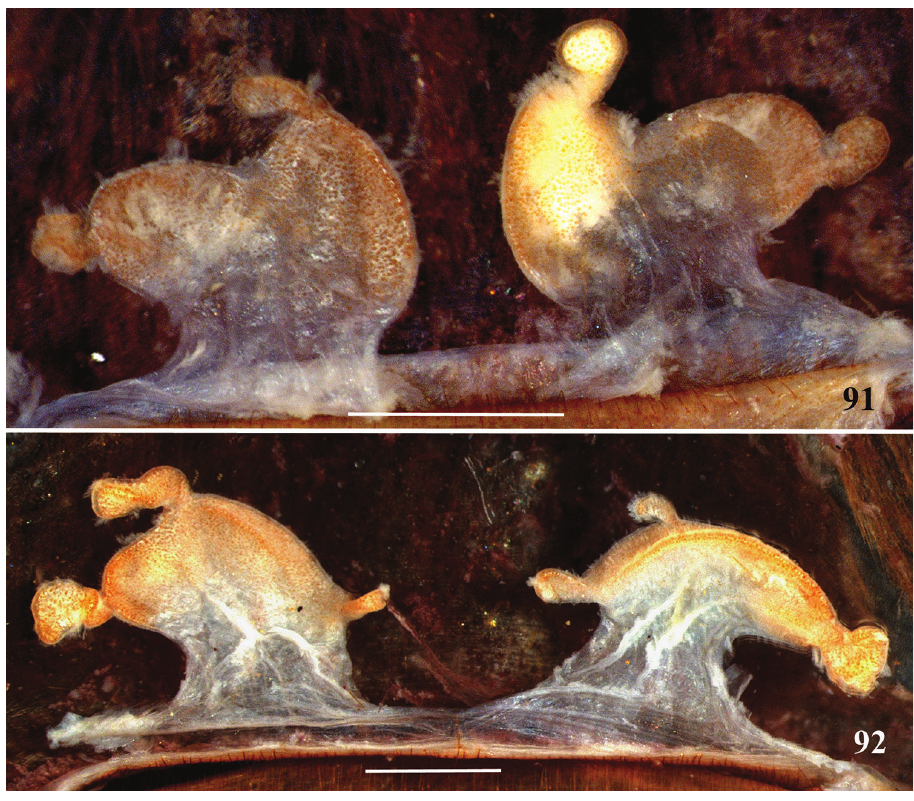
Figures 91–92. Avicularia taunayi (Mello-Leitão, 1920), spermathecae variation. 91 Sobradinho,